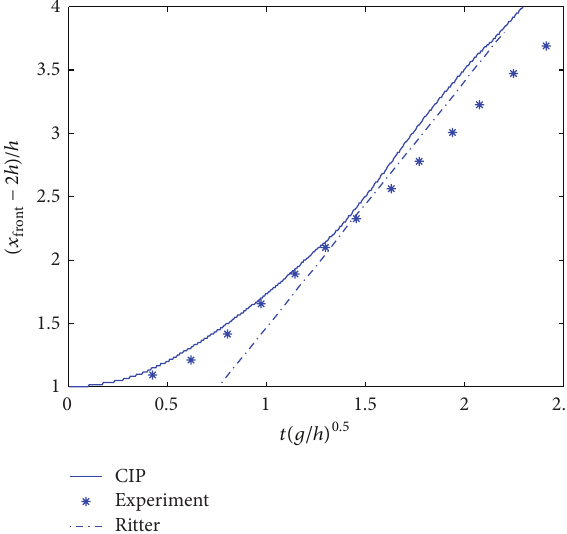
Figure 10: Conservation of liquid mass for different interface- capturing schemes.